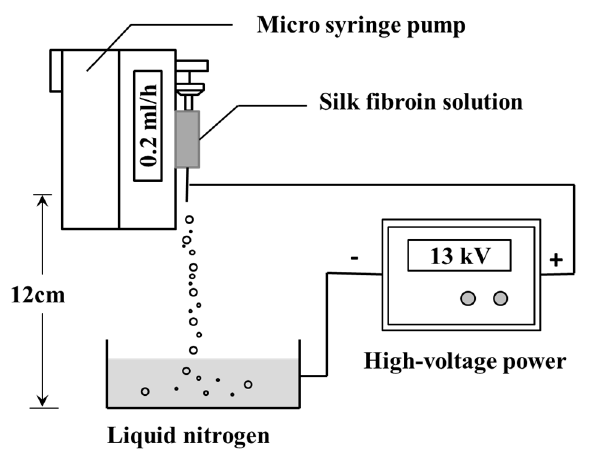
Figure 1. Schematic presentation of the preparation of silk fibroin nanoparticles (SFNPs) by high- voltage